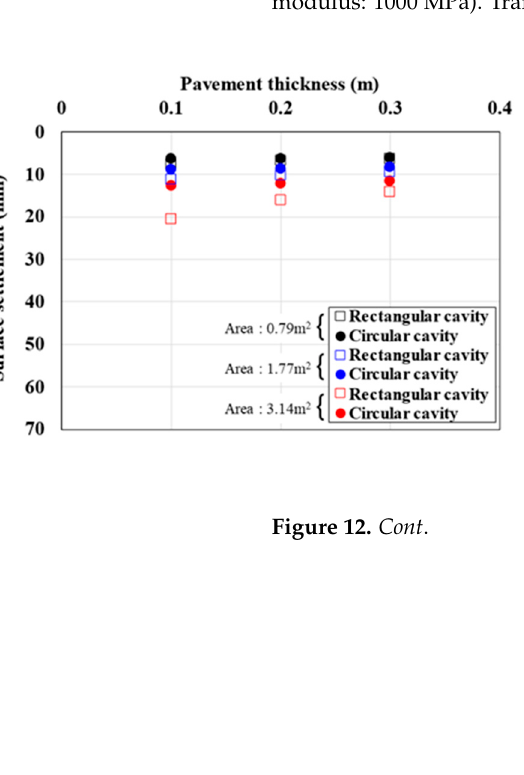
Figure 11. Surface settlement according to pavement thickness by cavity area (pavement elastic modulus: 1000 MPa). Traffic load: ( a ) 12.7, ( b ) 25.4, and ( c ) 38.1.